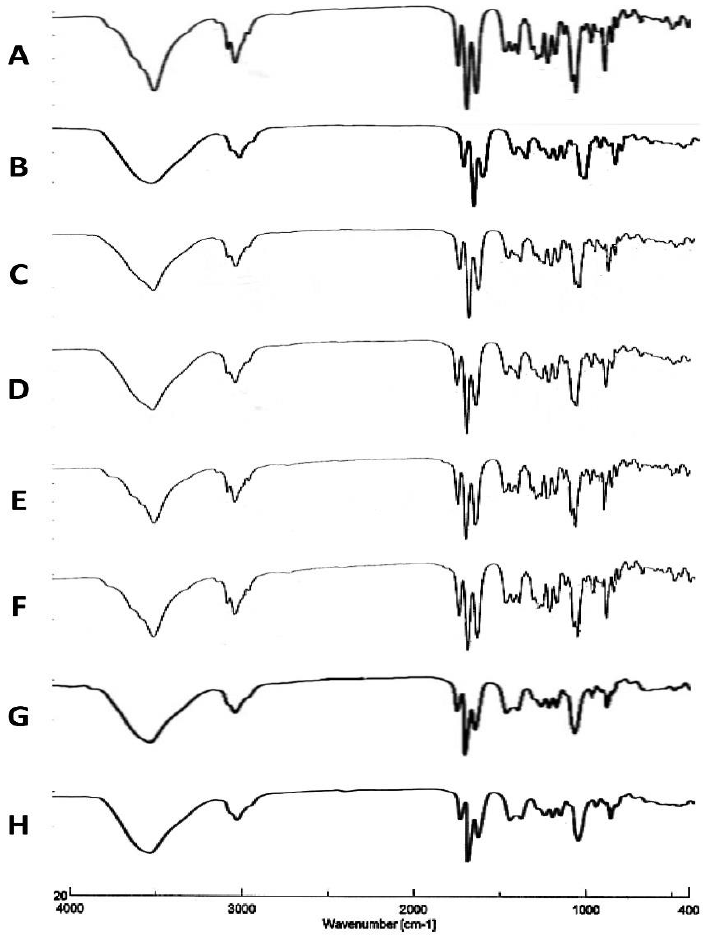
Figure 3. FTIR scans of different TAA formulations. ( A ) Micronized TAA raw material unprocessed and ( B ) 1%, ( C ) 1.5%, ( D ) 2%, ( E ) 2.5%, and ( F ) 3% ( w / v ) TAA systems spray-dried from 90% ( v / v ) ethanol, ( G ) 1% TAA system spray-dried from 70% ( v / v ) ethanol, and ( H ) 1% TAA system spray-dried from 80% ( v / v ) ethanol.